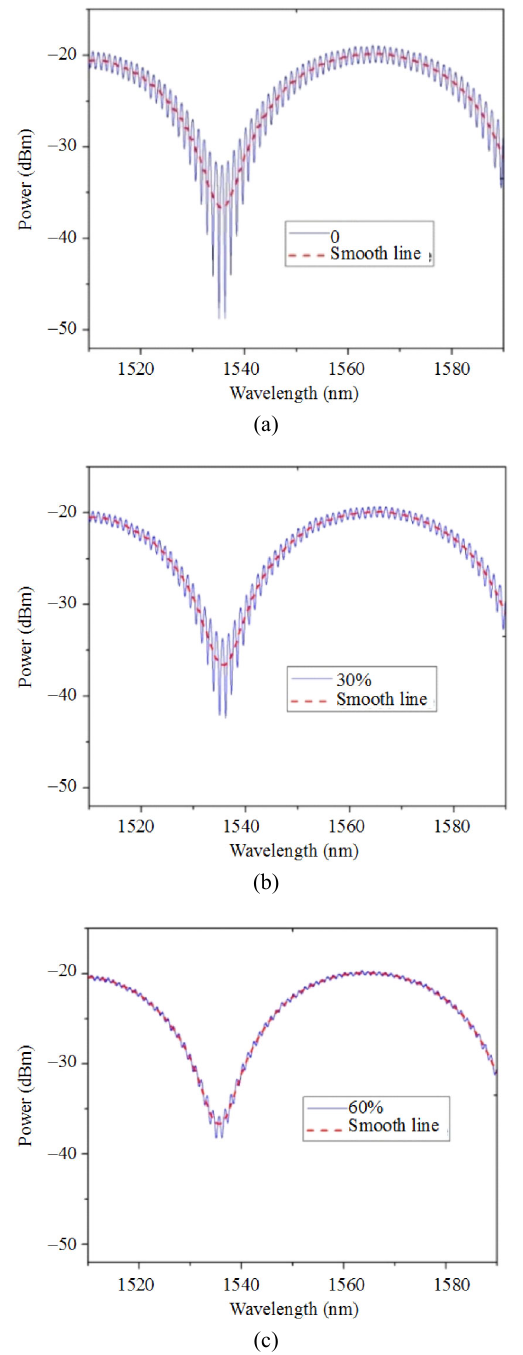
Fig. 7 Interference spectra (solid line) and smoothed spectra (dashed line) of the FPI in solutions of different concentrations corresponding to different RI: (a) 0, (b) 30%, and (c) 60%.